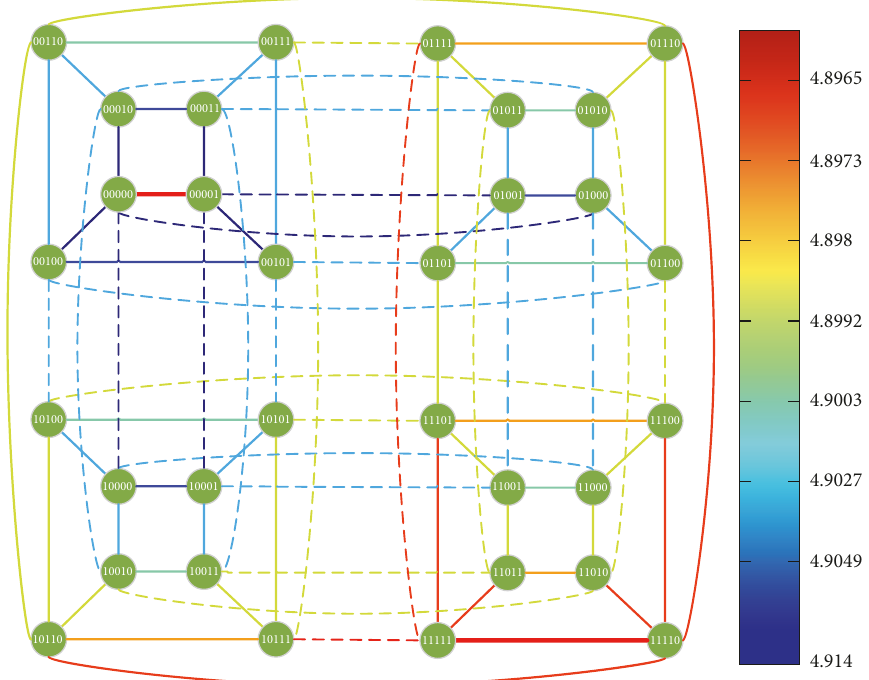
Figure 3: Assume that the red edge in the upper-left 3D subcube of 𝐻 5 is the first deleted edge and each of the remaining edges is a candidate for the second deleted edge. The spectral radius of the surviving network formed by deleting each of the candidate edges from 𝐻 5 is shown.